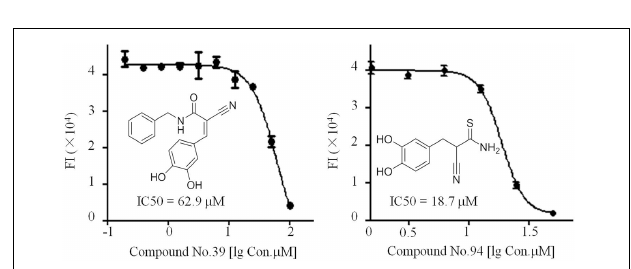
FIGURE 5 | IC 50 assays of compounds No.39 and No.94 toward the dsRNA formation catalyzed by truncated